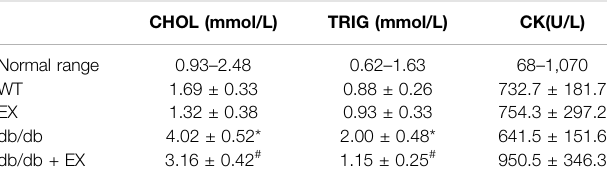
TABLE 1 | Effects of exercise on the biochemistry of diabetic mice (±SD, n =